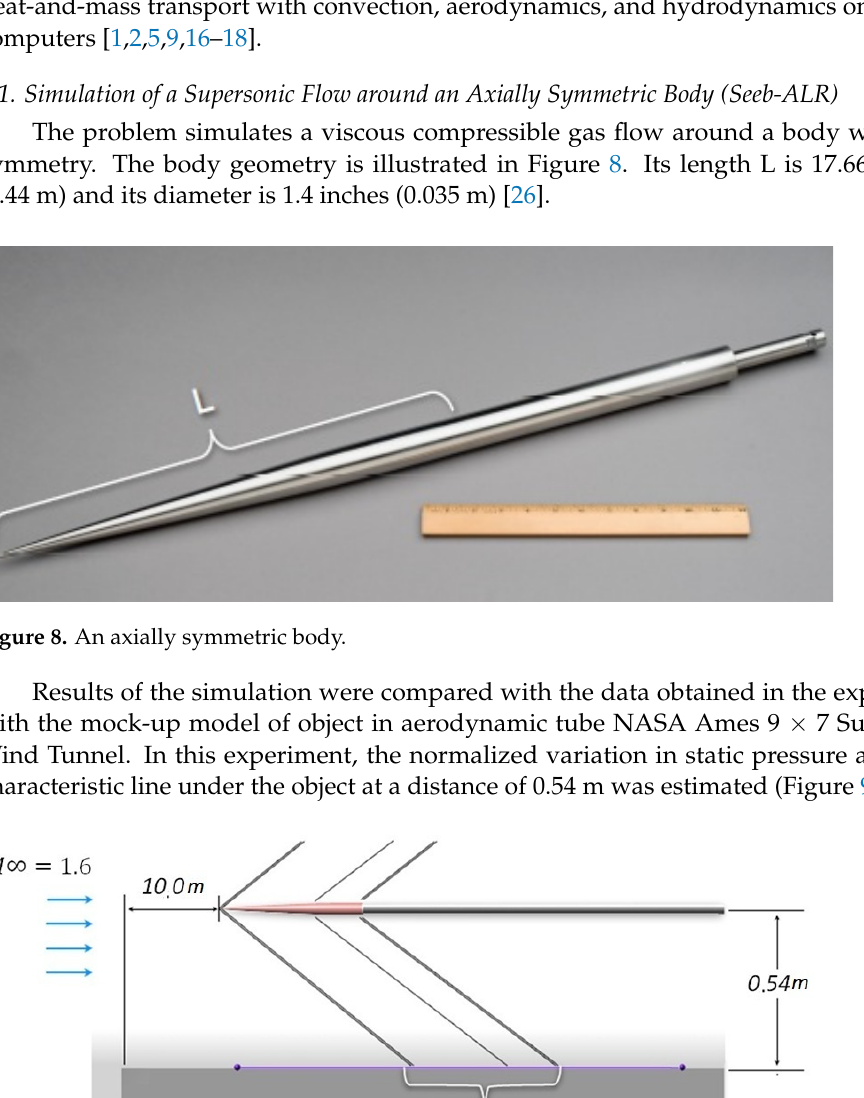
Figure 7. Local refinement of computational grid.